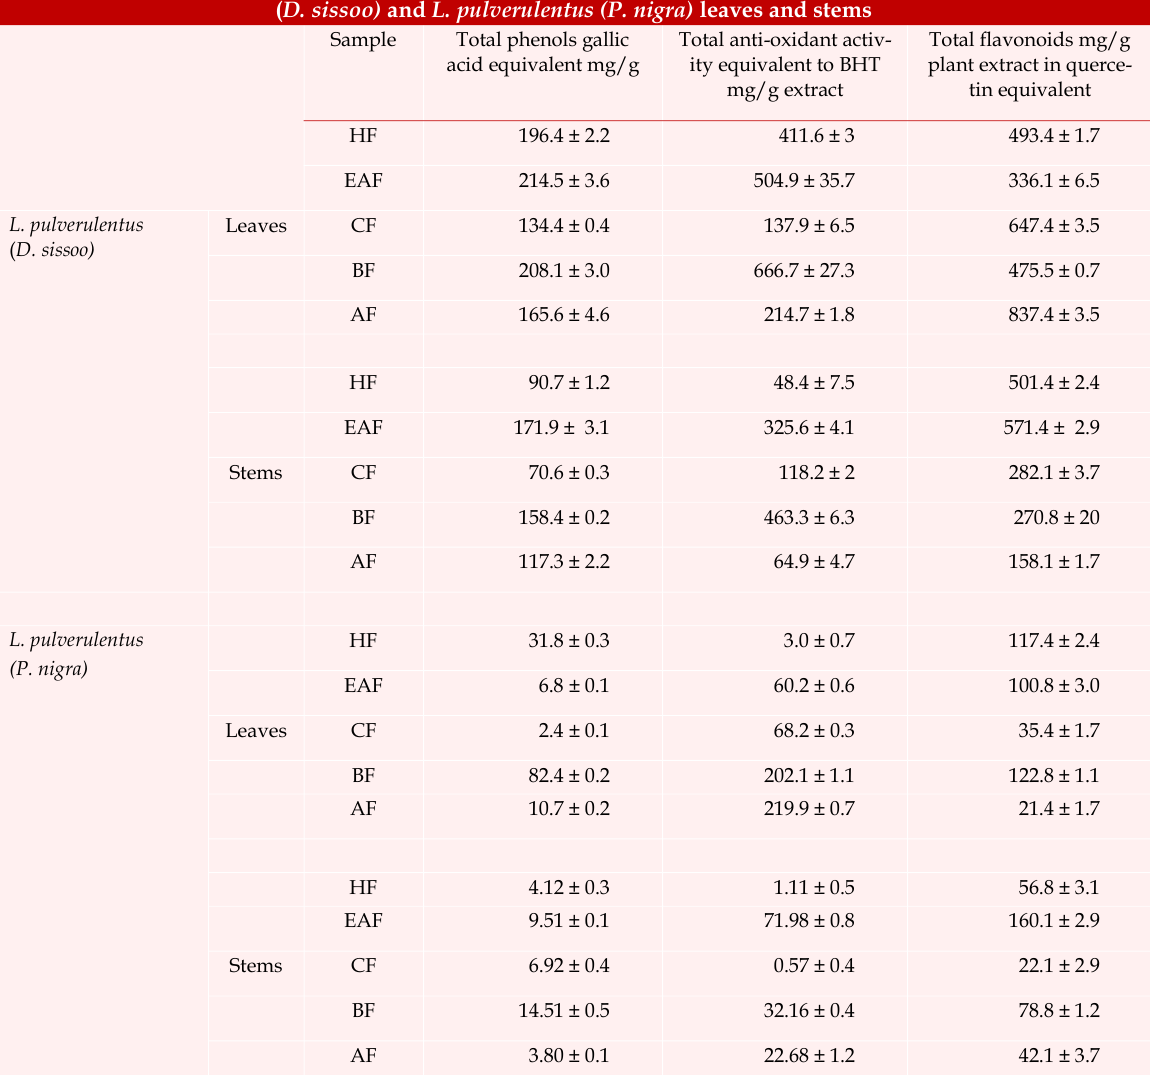
Total phenolic contents, flavonoids and anti-oxidant capacity of various fractions of L. pulverulentus ( D. sissoo) and L. pulverulentus (P. nigra) leaves and